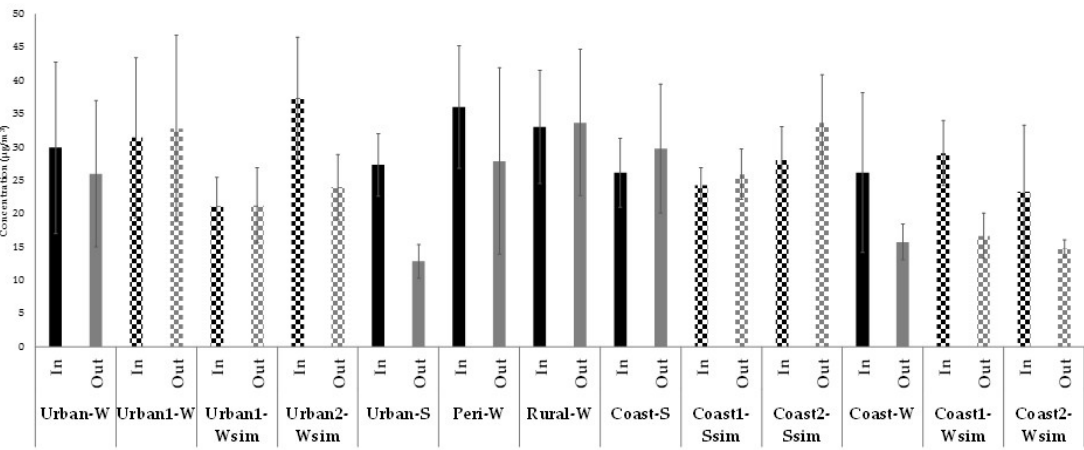
Figure 2. PM 2.5 concentrations and relative standard deviations (error bars) measured indoors and outdoors (in µ g / m 3 ): solid histograms refer to average values calculated between multiple campaigns; single campaigns are reported with a squared pattern.